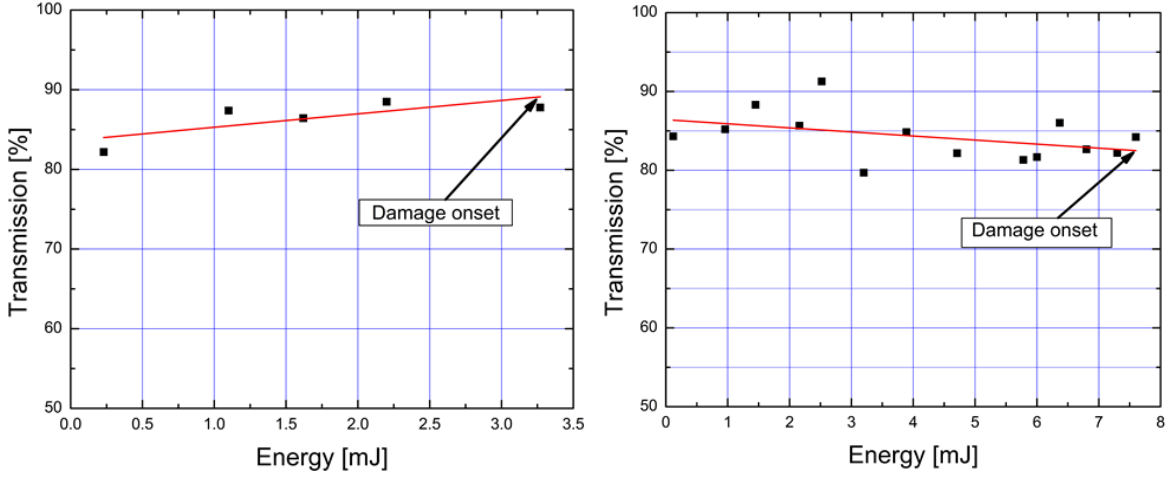
Figure 7. Examples of fiber transmission as input energy was increased, for cases where fiber fails within its length (12 ns pulse